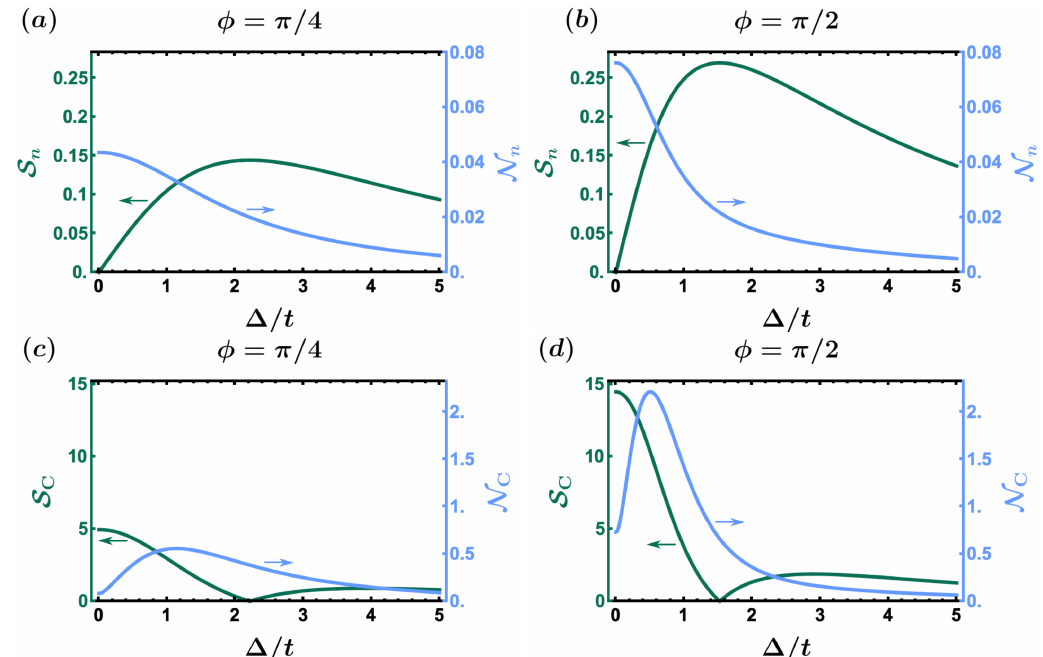
Figure 5: Signal (20) and noise (21) for the 2-MZM measurements of the 〉 (a)-(b) and differential QD capacitance C average QD charge 〈 n QD (c)-(d) as a function of detuning ∆ for different values of φ